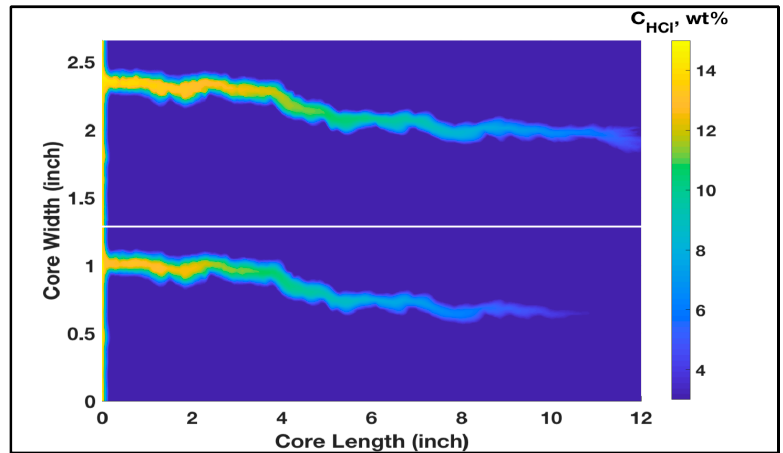
Figure 5. Concentration profile at the breakthrough for the HCl acid treatment with no diversion, showing a wormhole growing mainly in the high-permeability core sample.